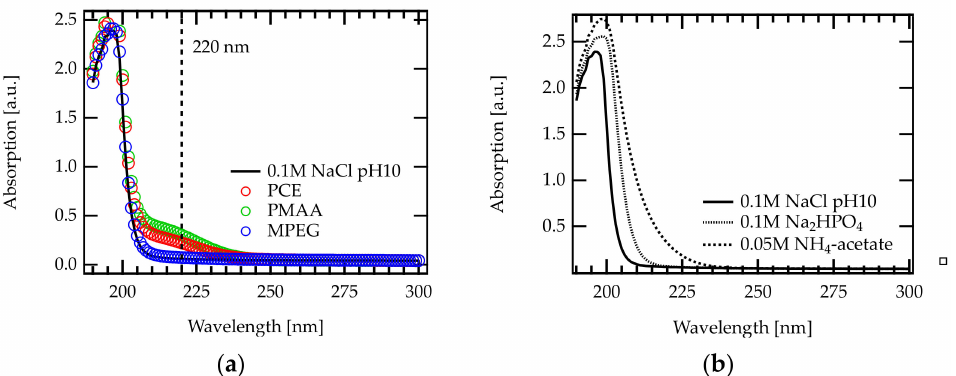
Figure A4. UV-Vis absorption spectra recorded between 190 and 300 nm: ( a ) various polymers dissolved in 0.1 M NaCl at pH 10. The UV cutoff of this solvent is located at approximately 210 nm. For PCE and PMAA solution, an absorption peak was found at 220 nm. MPEG does not show an absorption peak in the recorded range. ( b ) Different aqueous salt/buffer solutions that are frequently used in SEC analysis of PCEs. The addition of salt/buffer affects the cutoff wavelength. Generally speaking, the detection wavelength has to be selected appropriately that the end group contribution compared to absorption of the repeating units is negligible. In particular for high molar mass polymers, this requirement is often fulfilled as the number of repeating units is much higher than the number of end